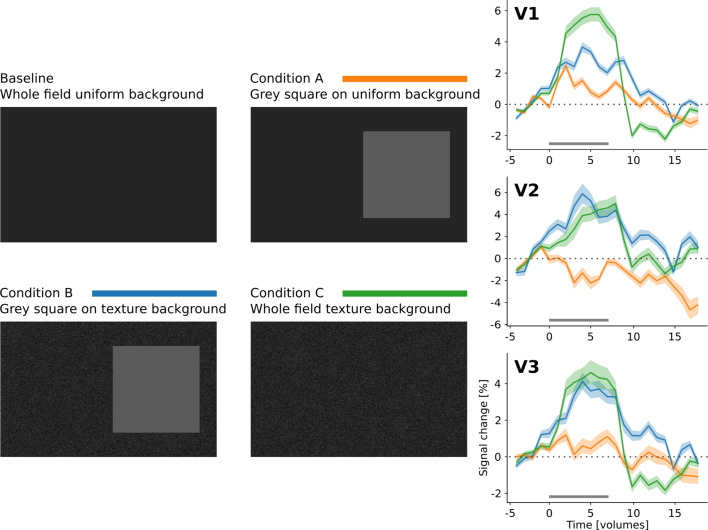
Additional control experiment, investigating the effect of a texture background on stimulus-induced responses relative to a uniform baseline (n = 1).The grey bar underneath the signal timecourses indicates the duration of the stimulus. Time is given in volumes; the duration of one volume was 2.604 s.